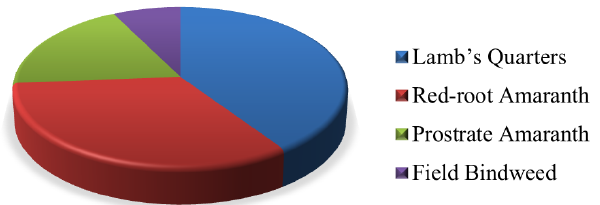
Fig. 1. Biomass of major weeds at dry bean harvest time